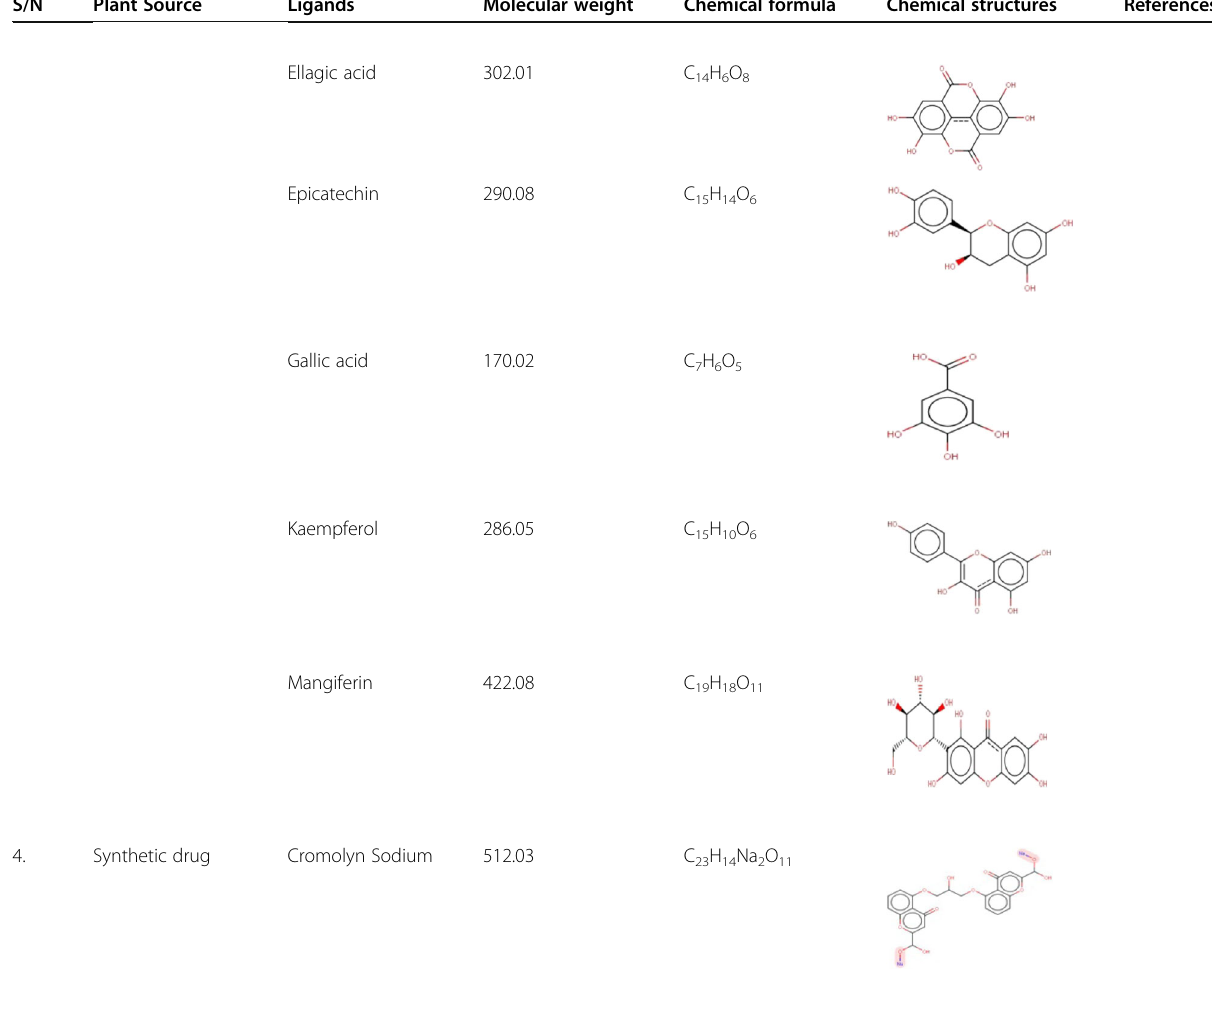
Table 1 Chemical Structure of bioactive compounds in A . indica , C . glaucum , and M . indica (Continued) S/N